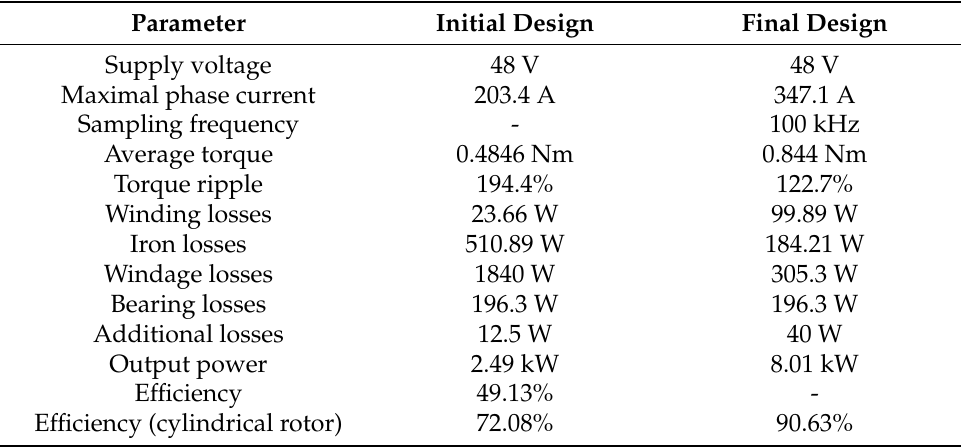
Table 10. Comparison of the electromagnetic